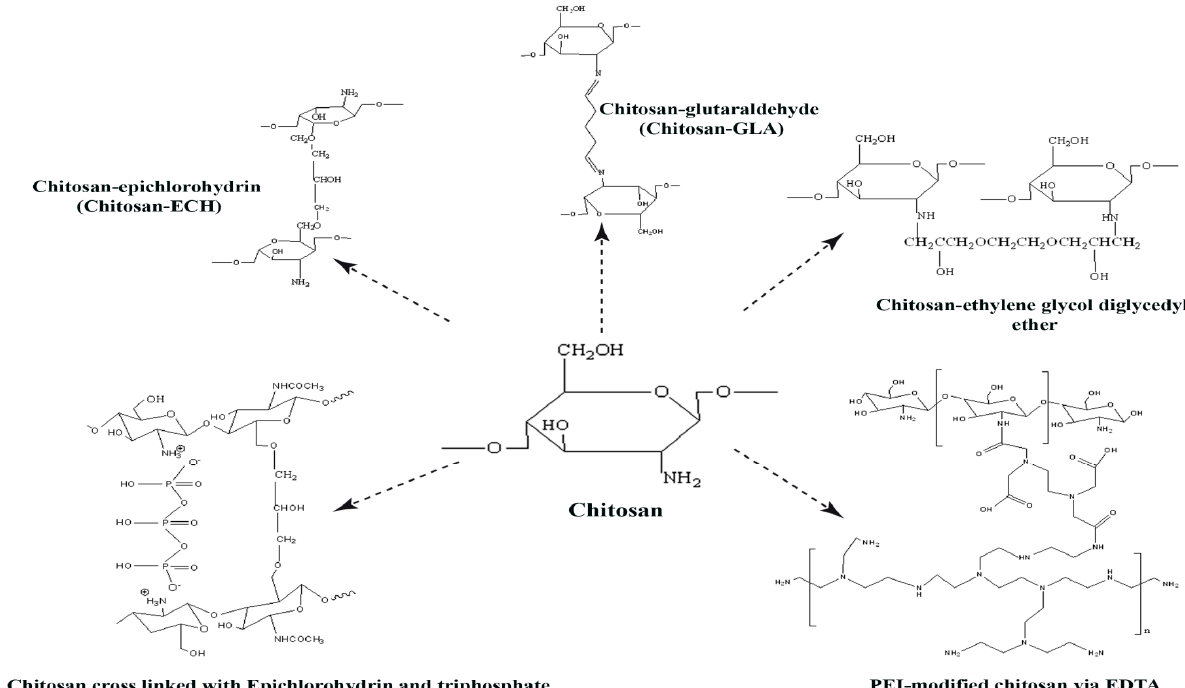
Figure 2. Schematic representation of chitosan and the possibility of cross-linked chitosan; chitosan-glutaraldehyde(chitosan-GLA), chitosan-epichlorohydrin (chi- tosan-ECH), chitosan-ethylene glycol diglycidyl ether (chitosan-EGDE), c ross-linking of chitosan with epichlorohydrin and triphosphate and polyethyleneimine (PEI)-modified chitosan via ethylenediaminetetraacetic acid (EDTA).